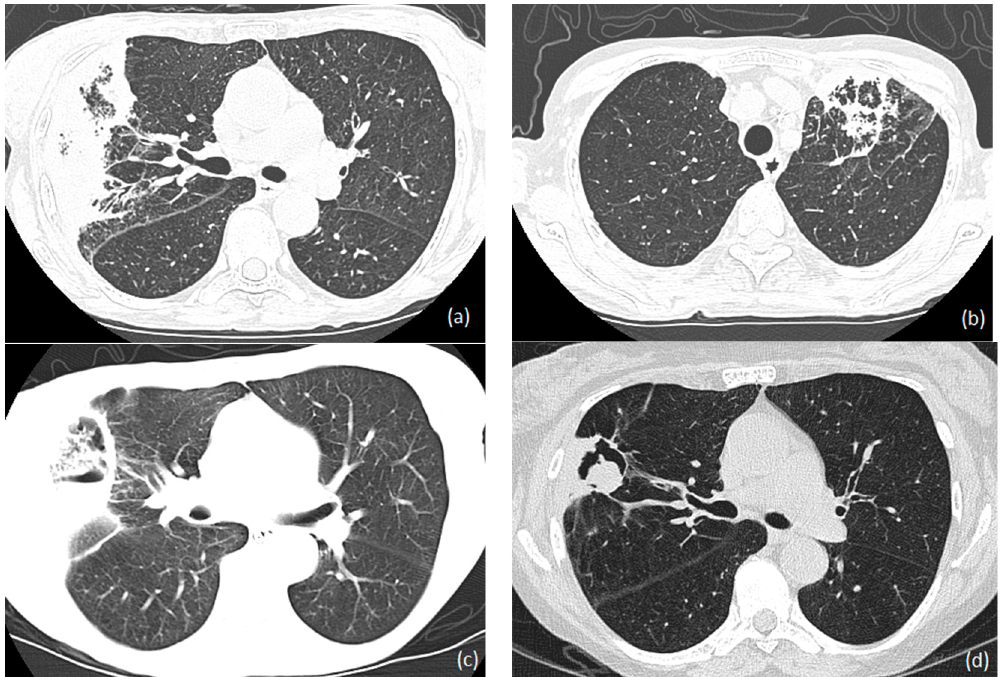
Figure 1. Chest X-ray of invasive aspergillosis in 58-year-old renal transplant recipient shows bilat- eral infiltrates.